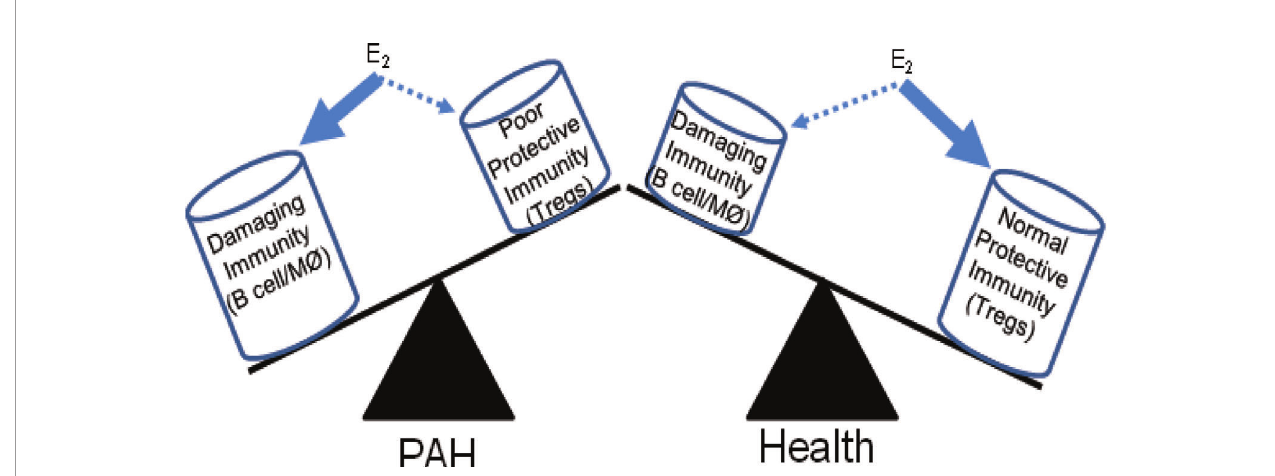
FIGURE 1 | Differential effects of estrogen on immunity in PAH and health. Estrogen (E 2 ) has complex effects on the immune response. In the absence of normal Treg immunity, E 2 may promote damaging B cell and macrophage responses that induce pulmonary vascular disease and PAH. In health, the positive effects of E 2 fostering Treg maturation may